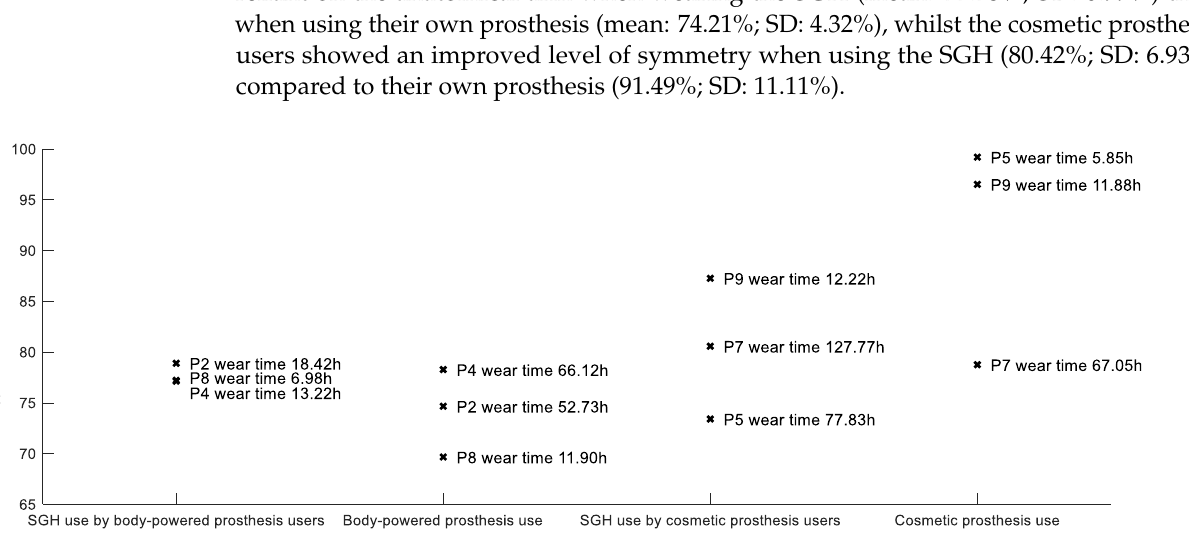
Figure 3. Median percentage reliance on the anatomical arm.